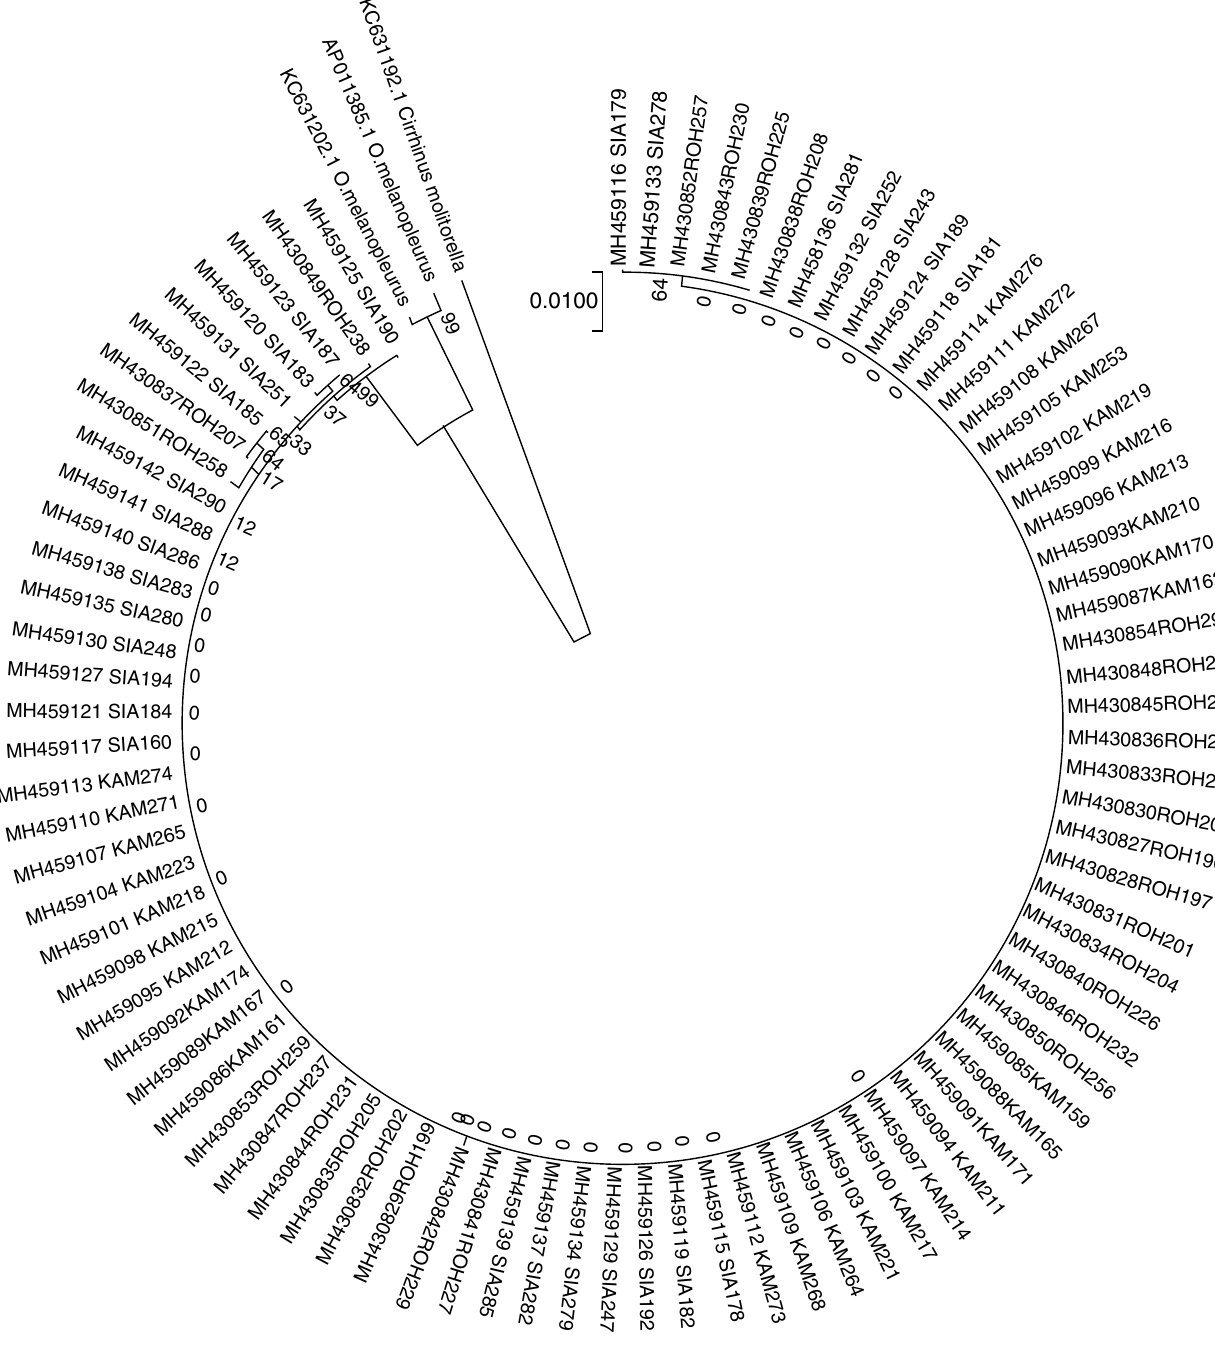
Figure 4. Phylogenetic tree of kelabau ( Osteochilus melanopleurus ) based on the neighbour-joining